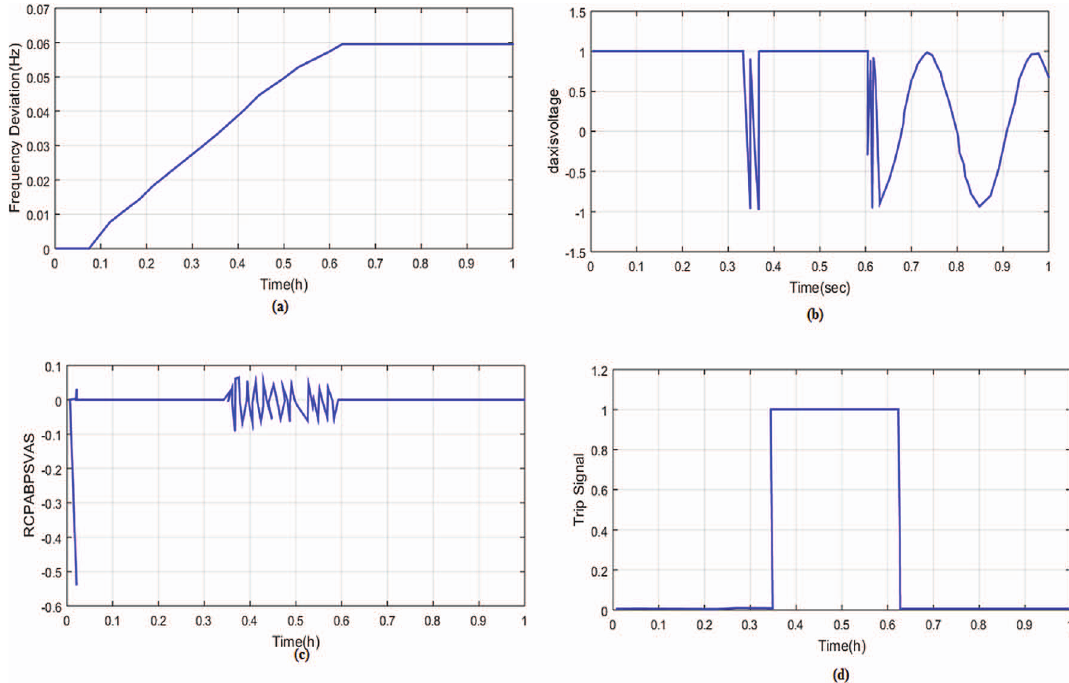
Fig. 11. System performance under overloading conditions, (a) frequency deviation versus time, (b) d -axis voltage versus time, (c) RCPABPSVAS versus time, and (d) trip signal versus time.